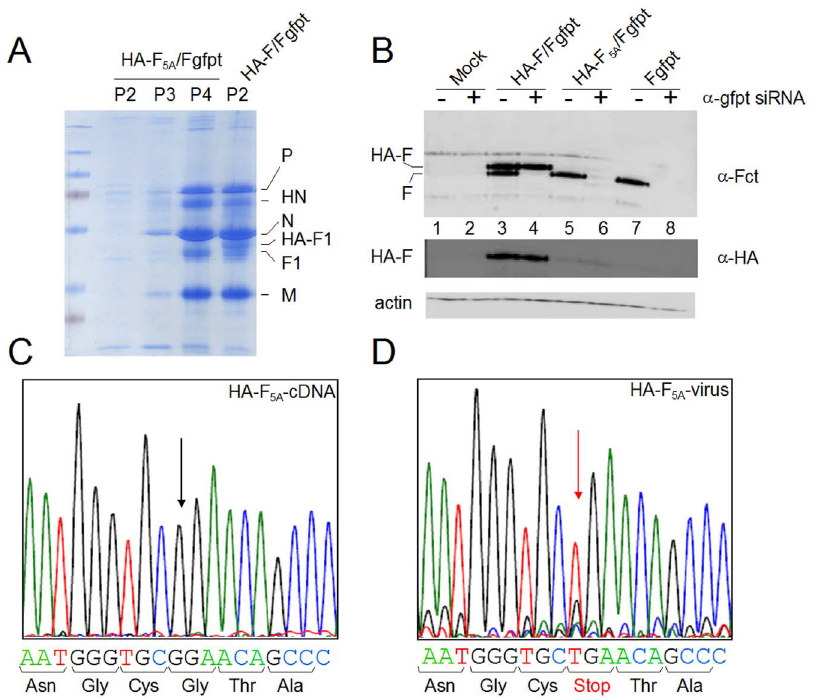
Figure 3. TYTLE/5A mutation of F is detrimental for SeV particle rescue. A . Coomassie blue stained PAGE analysis of virus purified from egg allantoic fluids. Lanes P2, P3, P4 (HA-F 5A /Fgfpt), 2 nd to 4 th egg to egg serial passages of rSeV-HA-F 5A /Fgfpt rescue. Lane P2 (HA-F/Fgfpt), 2 nd passage of rSeV-HA-F/Fgfpt rescue. B . Western blot analysis of MDCK cellular extracts obtained 24 hours after mock infection (Mock), infections with rSeV-HA- F/Fgfpt (HA-F/Fgfpt) or rSeV-HA-F 5A /Fgfpt (HA-F 5A /Fgfpt) in conditions of suppression or not of the endogenous wt-F proteins ( + / 2 a -gfpt siRNA). a -Fct : anti Fct antibody. a -HA: anti HA tag antibody. C . The cDNA fragment containing the HA-F 5A gene was purified after MluI digestion of the rSeV- HA-F 5A /Fgfpt full length cDNA clone and fully sequenced. D . The viral genomic RNA present in rSeV-HA-F 5A /Fgfpt infected cells was reverse transcribed using a primer of positive polarity in the M gene. The RT product was amplified using a primer of negative polarity in HA tag sequence. The RT-PCR product was then purified and fully sequenced. Arrows in C . and D . indicate the G to T substitution position leading to introduction of a STOP at position 37 in the F ORF (see also figure